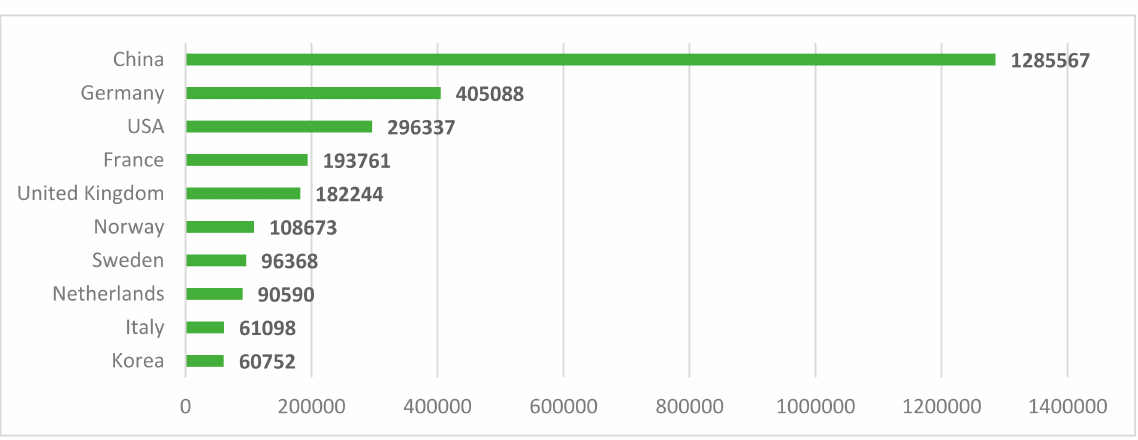
Figure 3. Top ten markets for electric vehicles by unit sales in 2020. Source: https://www.iea.org/articles/global-ev-data- explorer (accessed on 10 October 2021).